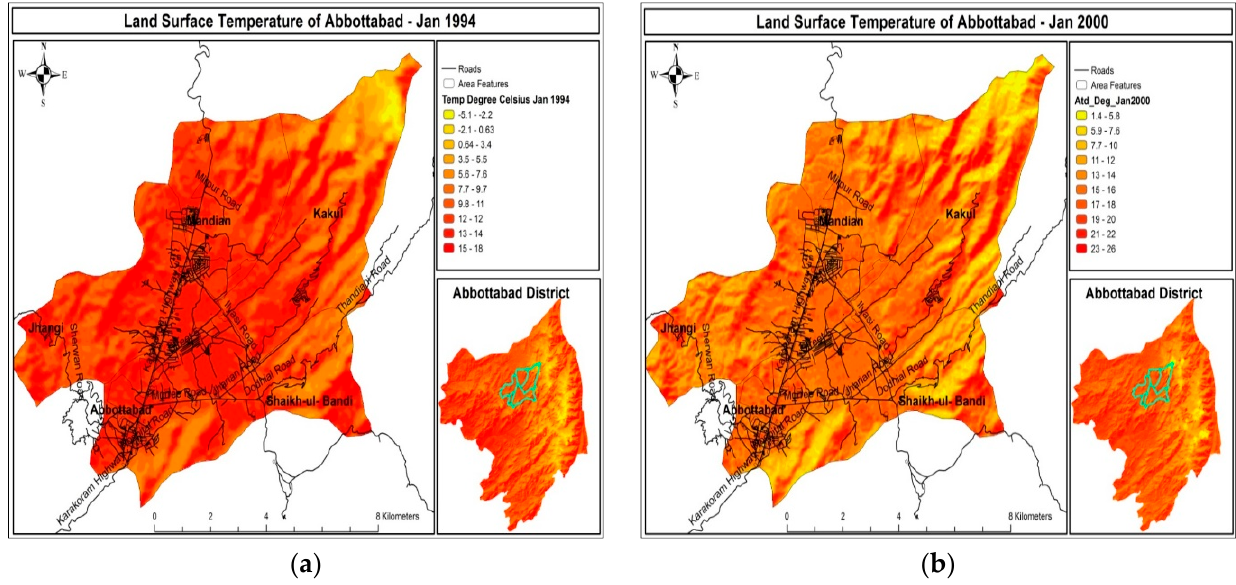
Figure 7. ( a ) LST of Abbottabad of Jan 1990–1994 and ( b ) LST of Abbottabad of Jan 1995–2000.